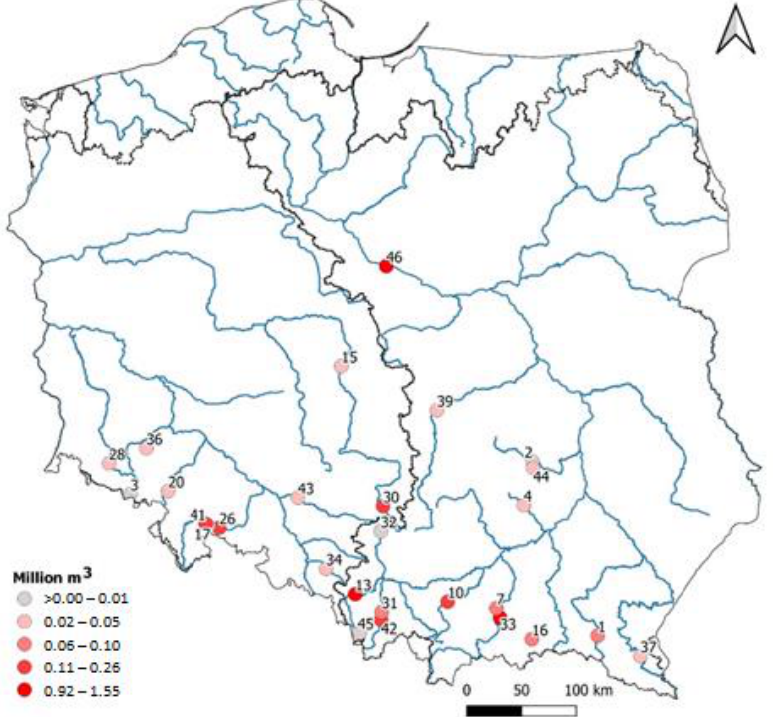
Figure 5. The average annual rate of loss of the capacity of reservoirs of key importance for water management in Poland, belonging to classes of capacity changes from I to III. Reservoirs: 1. Besko,